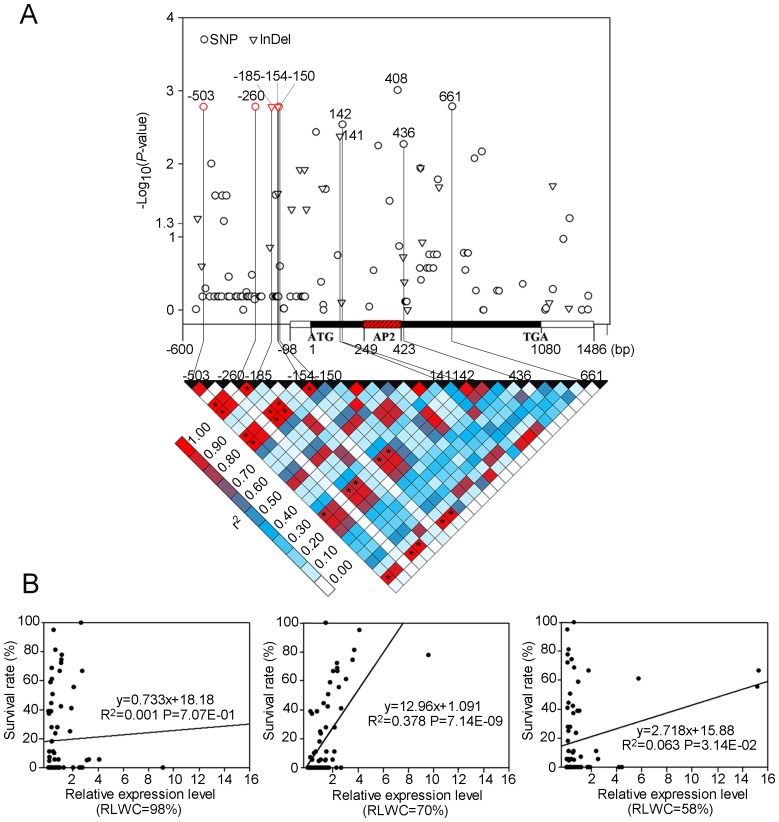
Association analysis of genetic variation ZmDREB2.7 with maize drought tolerance.(A) Association analysis of genetic variation ZmDREB2.7 with maize drought tolerance and the pattern of pairwise LD of DNA polymorphisms in the ZmDREB2.7 gene. A schematic diagram of the 2.1 kb genomic fragment, including 600-bp 5′-, 406-bp 3′-UTR, and the protein coding region are presented as the x-axis. The location of the initiation codon (ATG) is marked as “+1”. The P value is shown on a −log10 scale. The five significant polymorphisms in the 5′-UTR and four nonsynonymous variations in the coding region are connected to their locations on the gene diagram by solid lines. “*” indicates a strong LD (r2≥0.8) with these five polymorphisms. (B) Correlation analysis of survival rate with the relative expression level of ZmDREB2.7. Drought stress was applied to the maize seedlings after the RLWC was decreased from 98% (unstressed) to 70% (moderate drought) or 58% (severe drought).